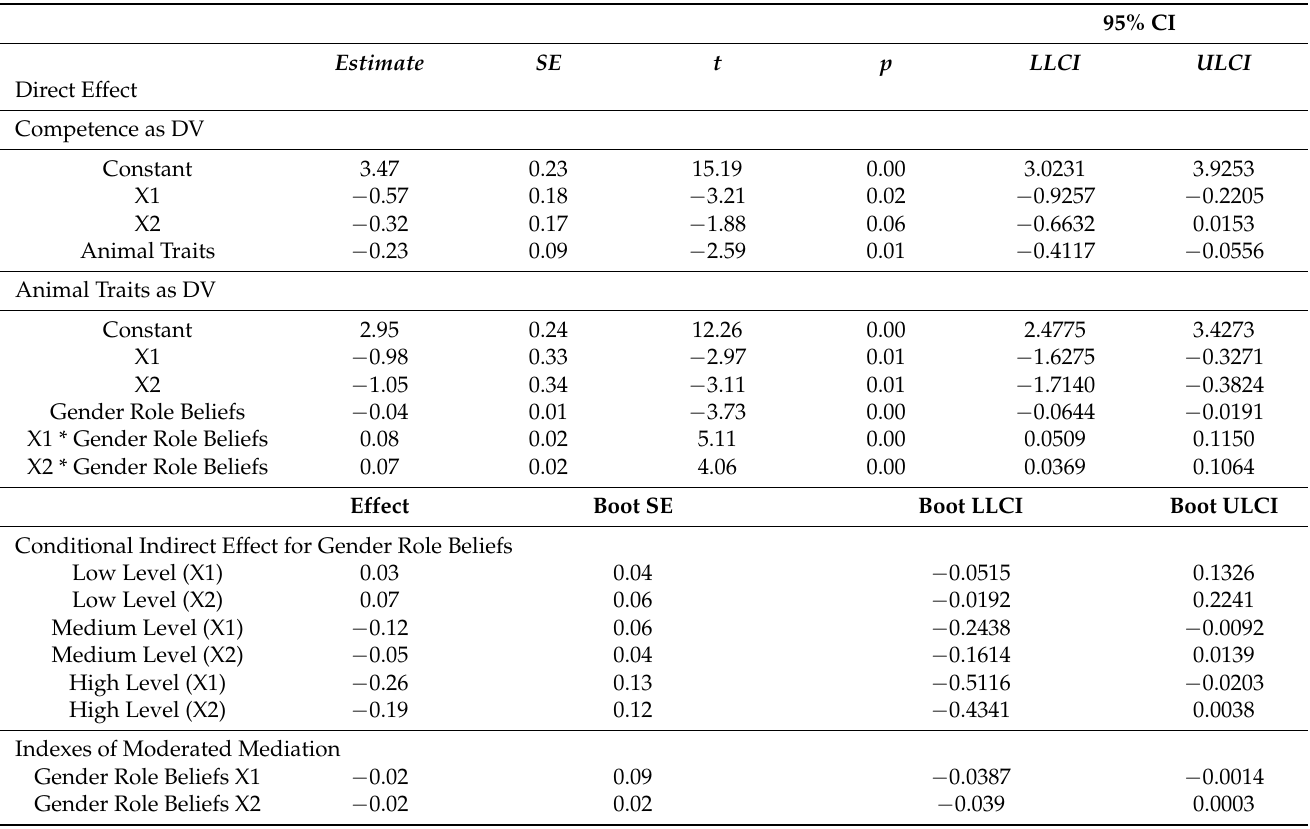
Table 1. Moderated-Mediation